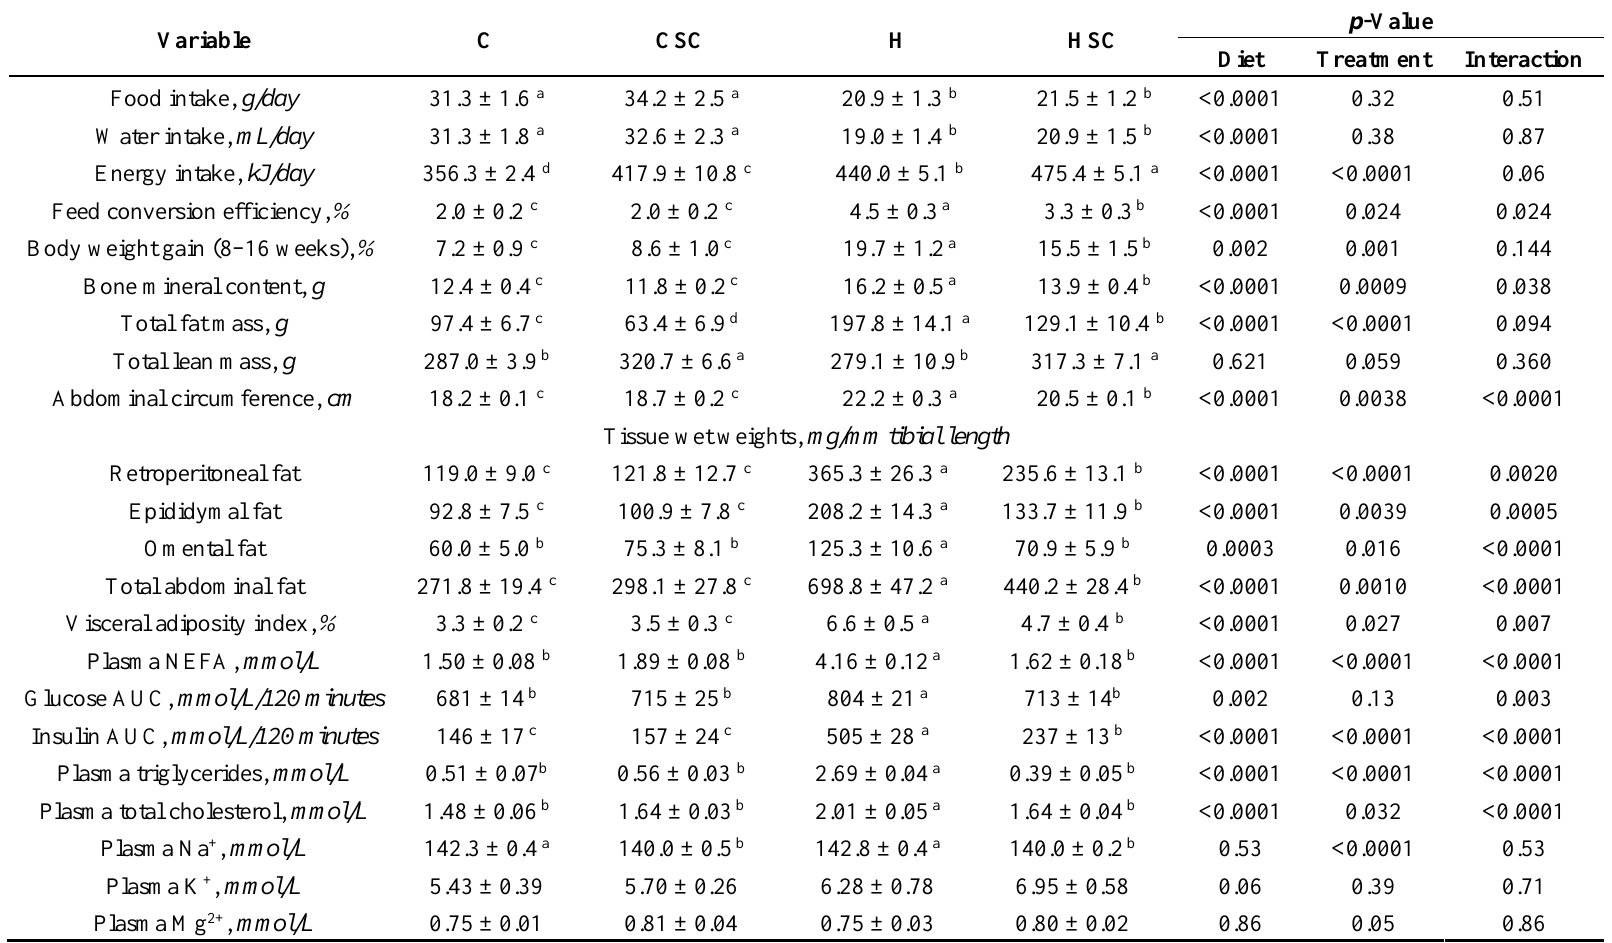
Table 2. Metabolic and biochemical variables in C, H, CSC and HSC